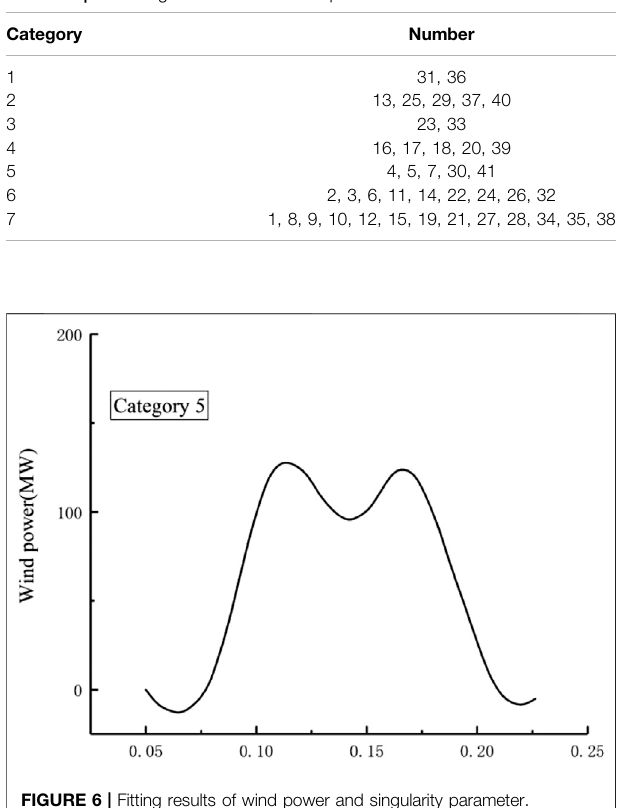
FIGURE 6 | Fitting results of wind power and singularity parameter.